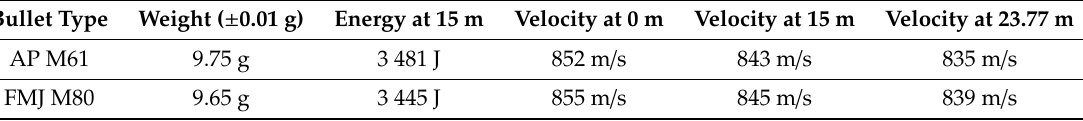
Table 1. Bullet velocities obtained in the experimental shots.